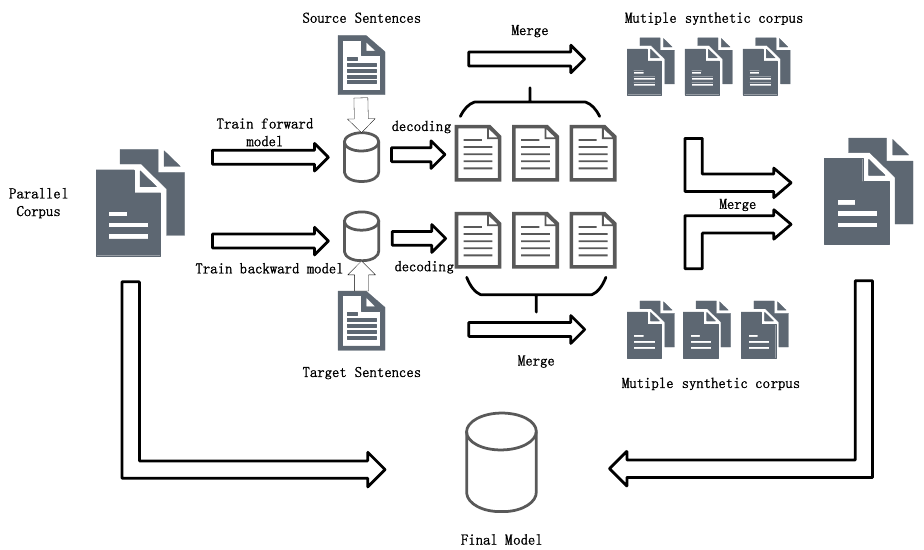
Figure 2. Overview of our data augmentation strategy.